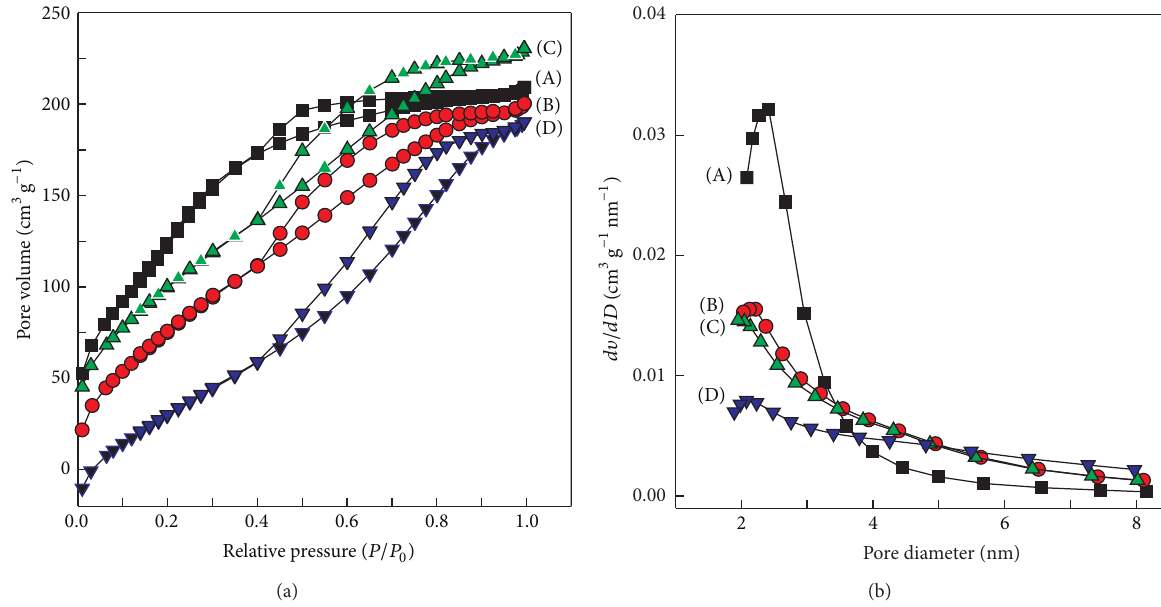
Figure 2: N 2 adsorption-desorption isotherms (a) and the corresponding pore size distributions (b) of MFMSNs (A), MFMSNs-HP (B),